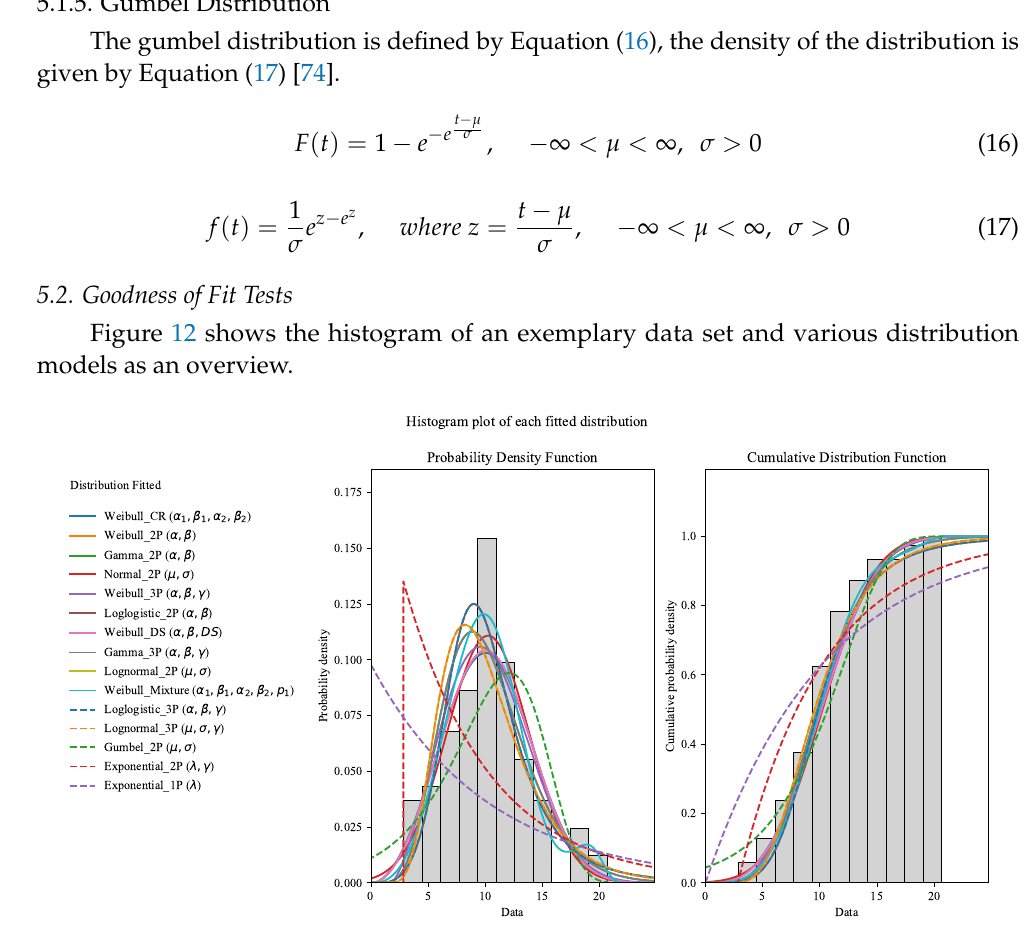
Figure 12. Example of a histogramm plot of the probability density function and the cumulative distribution function of fitted